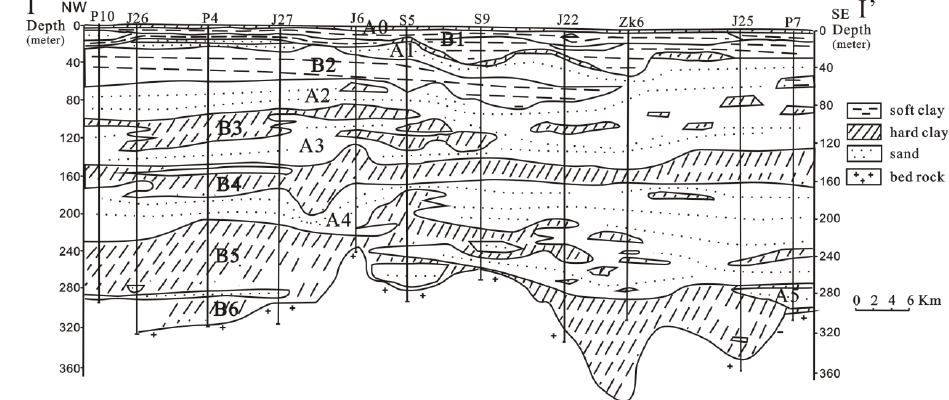
Figure 2. Schematic stratigraphic section in Shanghai (after Ye et al., 2011).